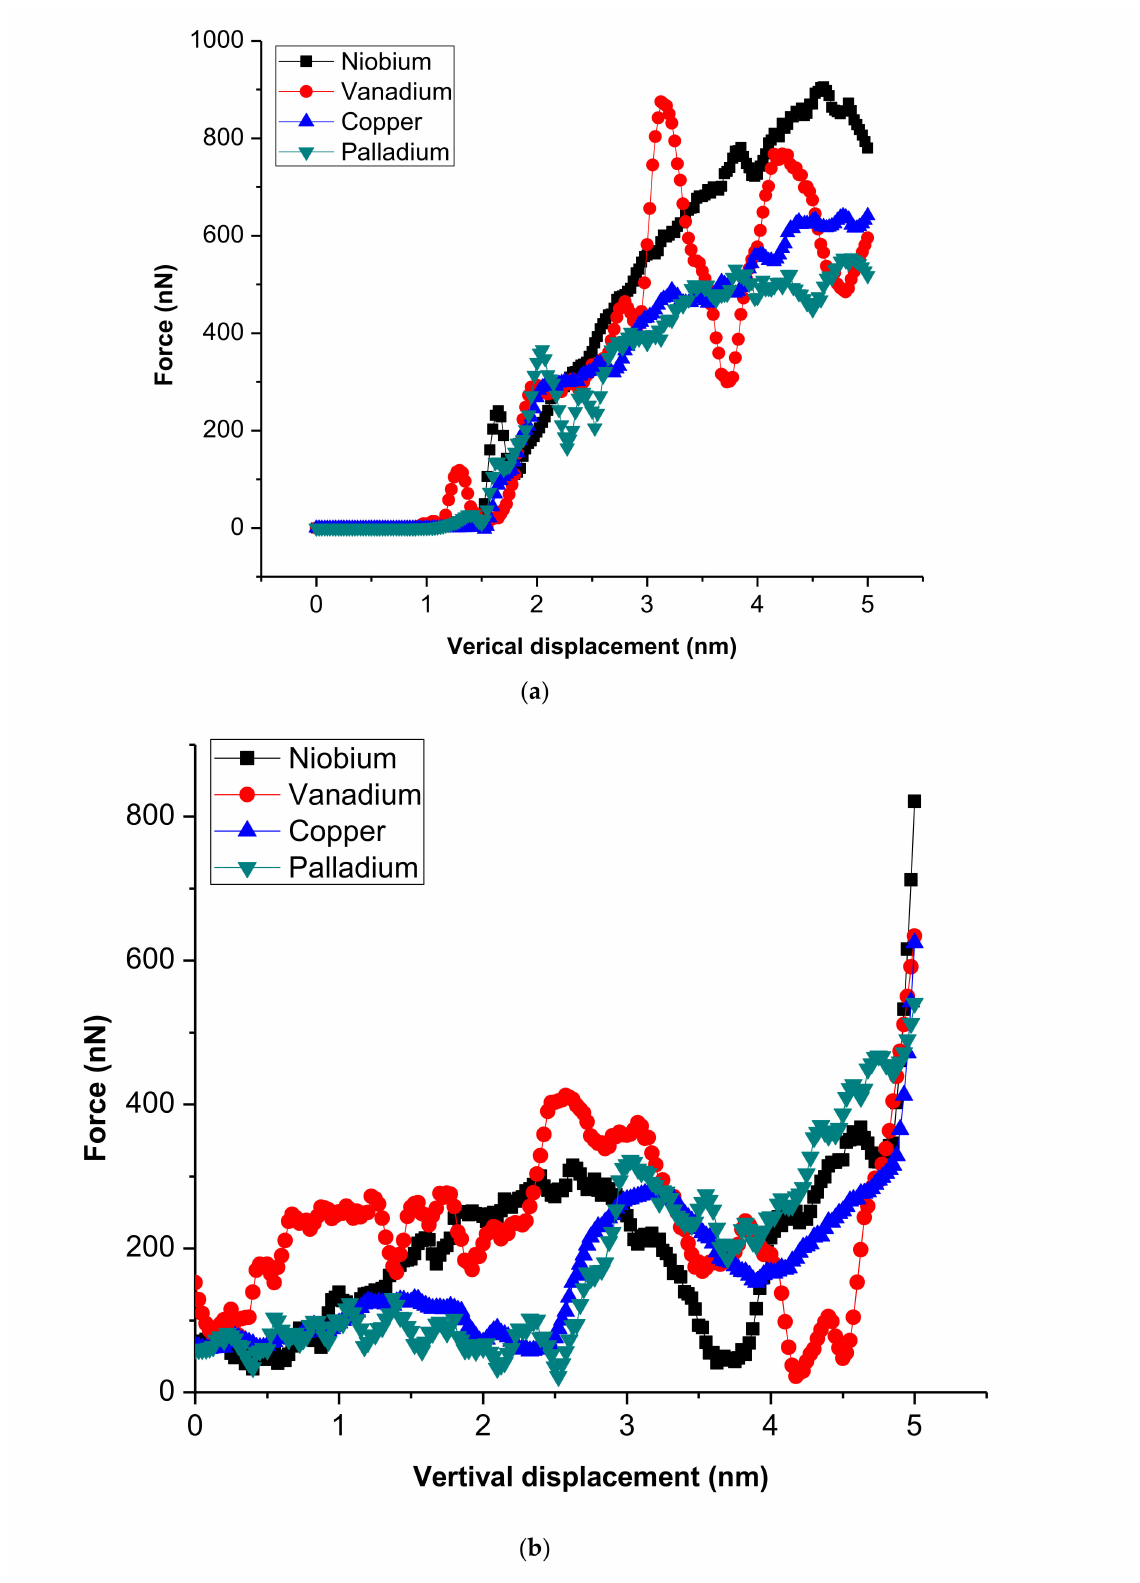
Figure 4. Force-displacement curves for ( a ) loading and ( b ) unloading process during the nanoindentation test of the thin films at 0.5 Å / ps loading